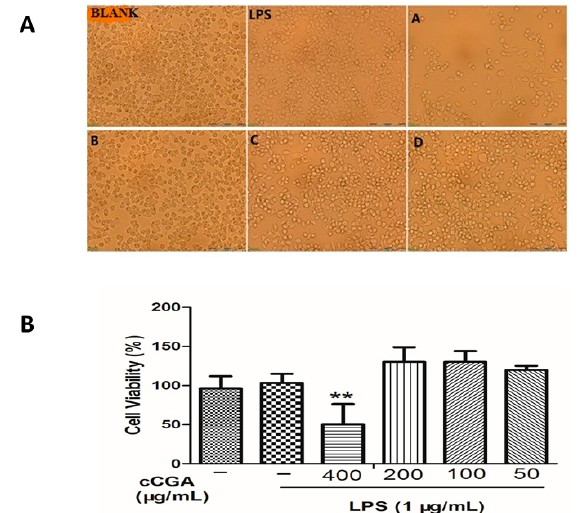
Figure 5. Cell morphology and viability after treatment with different concentrations of CCGA (BLANK: No LPS and CCGA treatments, LPS: Treatment with only LPS; A: 400 μ g/mL CCGA + 1